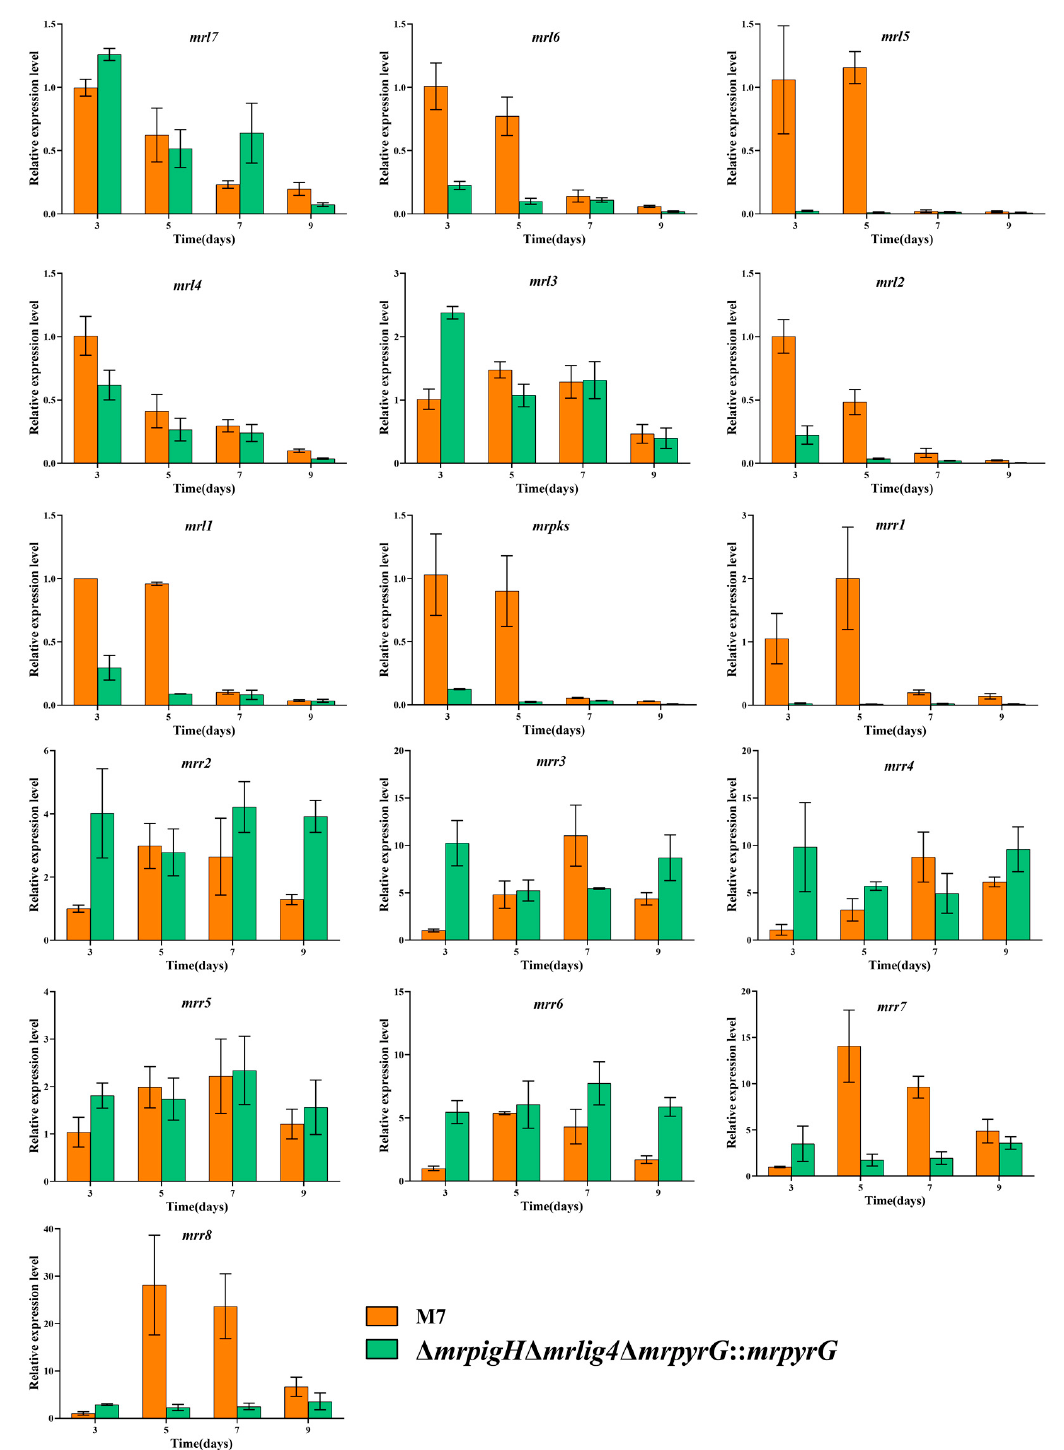
Figure 5. RT-qPCR analysis of the mrl7-mrr8 in M7 and ∆ mrpigH ∆ mrlig4 ∆ mrpyrG :: mrpyrG . mrl7 : Oxydoreductase; mrl6 :